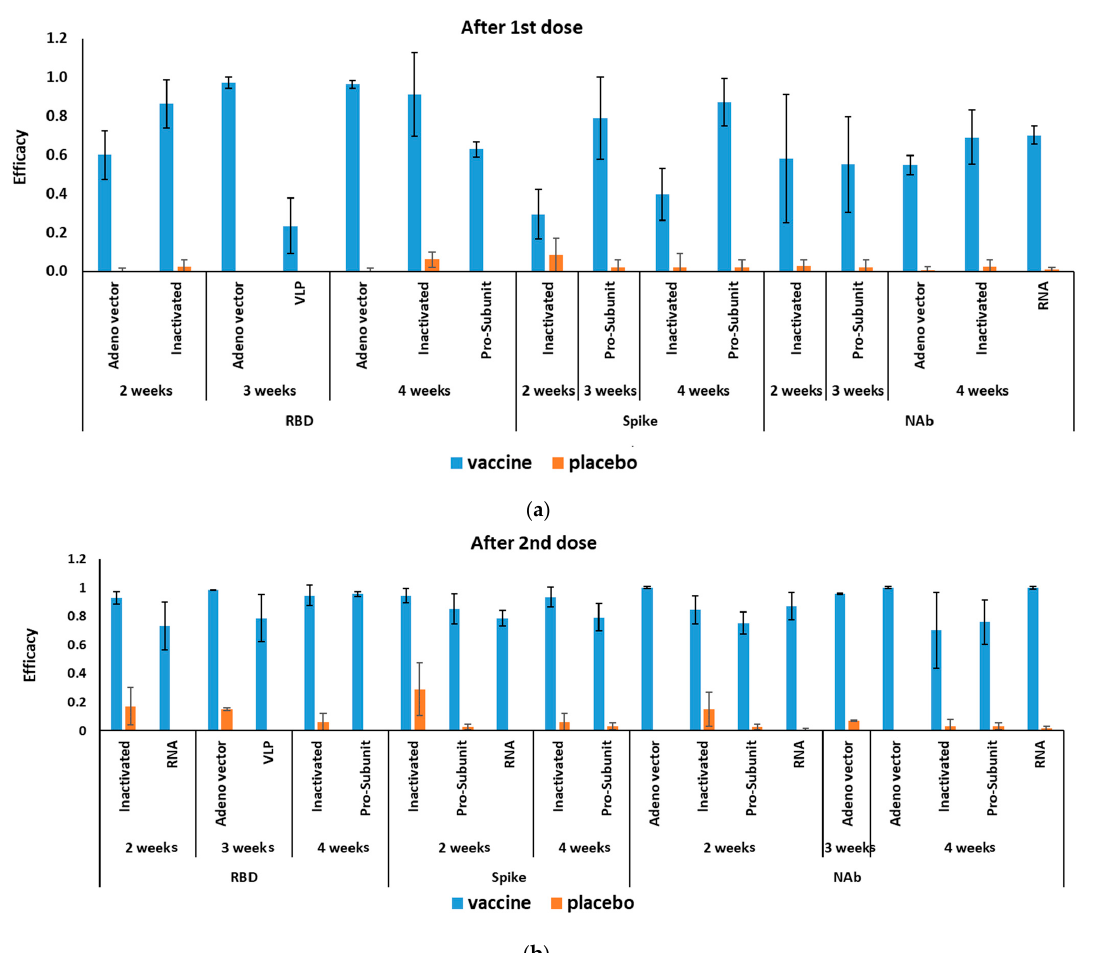
Figure 2 . Efficacy of different COVID-19 vaccines ( a ) after the first and ( b ) second doses. Table 3. Efficacy of different COVID-19 vaccines after the first and second doses. The administration of mRNA-based vaccine was associated with a greater number Vaccine of side effects, such as injection site pain, fever, redness, swelling, induration, pruritus, chills, myalgia, arthralgia, vomiting, fatigue, and headache, by yielding a summary OR of 83.06 (95% CI 37.05–186.1) (in phase II/III RCTs), 36.90 (95% CI 12.34–105.21) (in phase I/II/III RCTs), 24.40 (95% CI 18.73–31.77) (in phase I/II/III RCTs), 18.79 (95% CI 4.87–72.40) (in phase I/II/III RCTs), 17.5 (95% CI 1.96–155.58) (in phase I/II RCTs), 17.50 (95% CI 1.98–155.58) (in phase II/III RCTs), 13.11 (95% CI 7.19–23.89) (in phase II/III RCTs), 10.71 (95% CI 6.51–17.60) (in phase I/II RCTs), 9.67 (95% CI 1.27–76.90) (in phase III/II RCTs), 8.71 (95% CI 4.38–17.34) (in phase I/II RCTs), 6.16 (95% CI 5.86–6.48) (in phase III RCTs), and 5.13 (95% CI 2.32–11.31) (in phase I/II RCTs), respectively, compared to other types of vaccines. Nevertheless, the adenovirus-vectored vaccine was associated with higher rates of diarrhea with OR of 4.59 (95% CI 3.58–5.89), and arthralgia OR of 10.61 (95% CI 7.60–14.83) compared to others (Table 4). It should be considered that heterogeneity (I- squared test) of the pooled meta-analysis for most of the side effects was low (I2 < 50%), which indicates that variation in study outcomes between the included studies was low, even though different companies and different research groups across the world have been included. More detailed information such as Forest plot, Funnel plot, heterogeneity test, and sub-group analysis of each side effects are shown in Figures S1–S21 (in the Supplementary